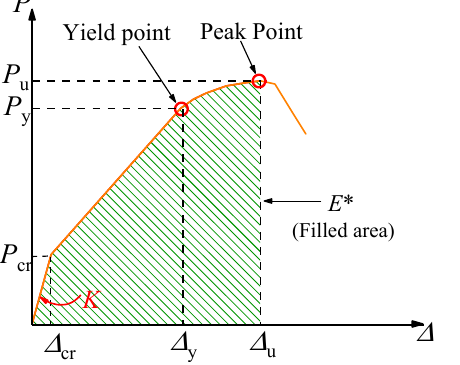
Figure 7. Calculation diagram of energy consumption index and ductility index.